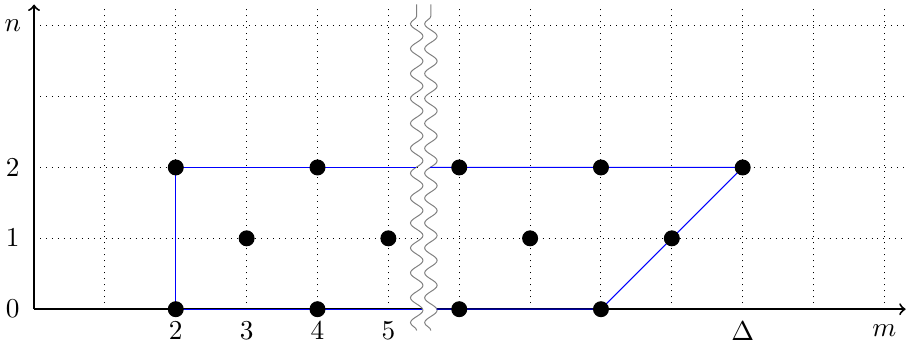
Figure 1. Admissible Lorentz labels of zero-forms for even ∆ .